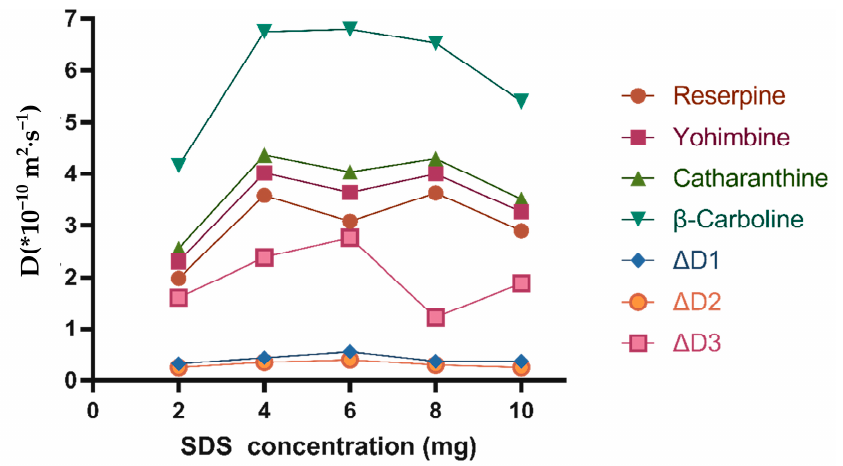
Figure 6. The influence of SDS concentration on the diffusion coefficient and resolution. Mixtures (each component was 2 mg) and SDS (2 mg, 4 mg, 6 mg, 8 mg, and 10 mg) were dissolved in 600 µ L of DMSO- d 6 when T was set at 298 K.